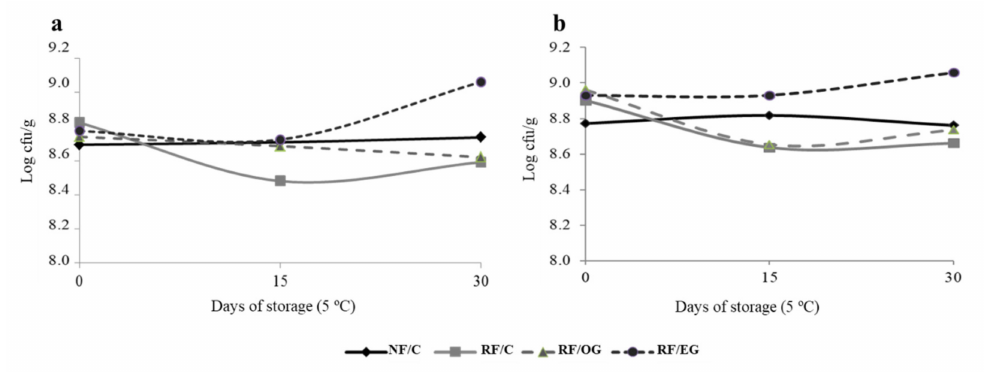
Figure 2. Microorganism ( a : total viable count; b : lactic acid bacteria) counts (log cfu / g) of fuets during 30 days of chilled storage. For sample denominations see Table 1.